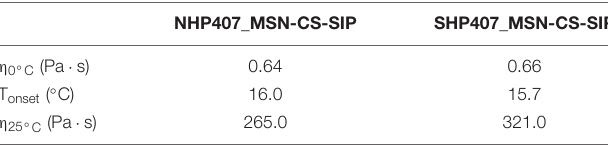
TABLE 4 | T onset , η 0 ◦ C and η 25 ◦ C of NHP407_MSN-CS-SIP and SHP407_MSN-CS-SIP hydrogels estimated from rheological temperature ramp